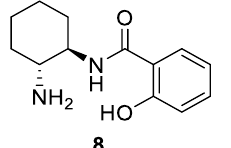
Figure 2. Organocatalyst employed in this study.